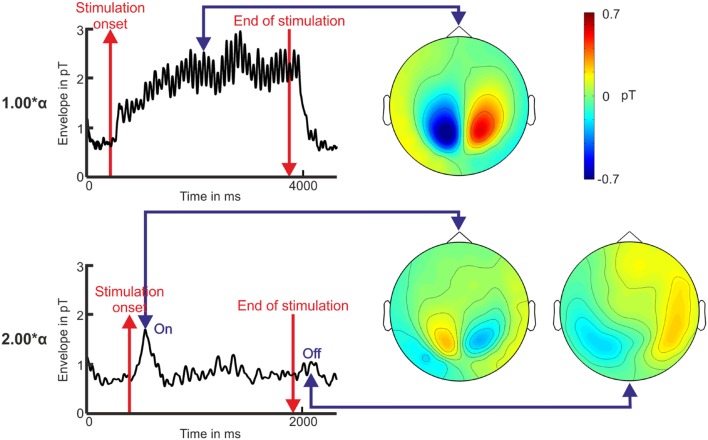
Envelope over time and topography of the magnetometer signals illustrating the photic driving effect at 1.00∗α and the on-/off-response for the stimulation with 2.00∗α for volunteer P10. Baseline is displayed 500 ms before the stimulation onset and 1 s after the end of the stimulation (red lines). The blue arrows mark the time points that the topographies display.